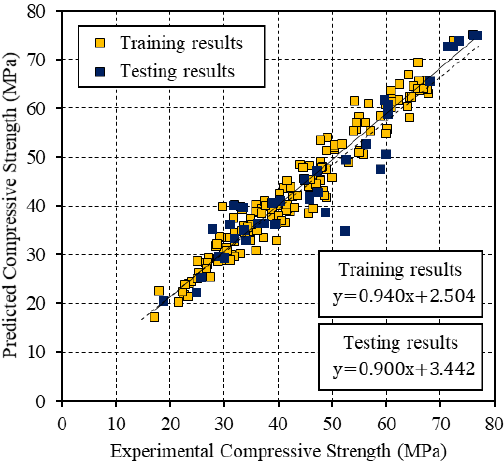
Figure 4. Comparison between the experimental CS and that predicted by the BP neural network.